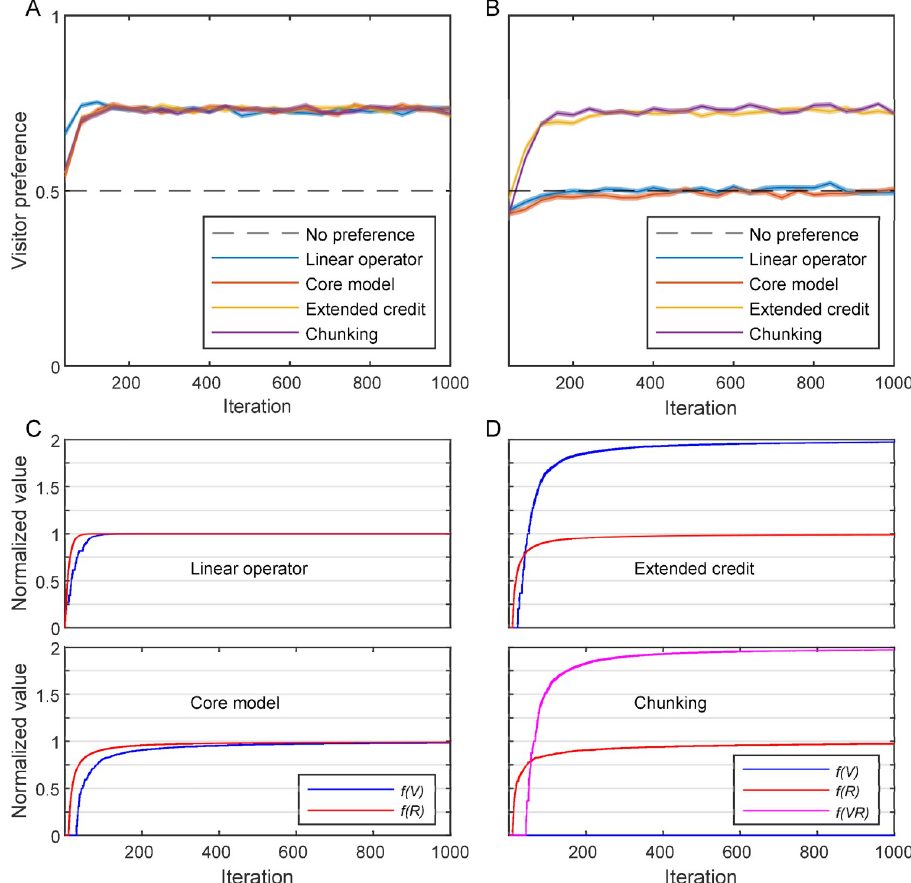
Fig 3. Simulating laboratory environments. Four types of learners are compared in the ‘basic two-choice task’ (A) and the ‘laboratory market problem’ (B) : blue–A linear operator learner ( α = 0.1; see text); orange–the core model; yellow–the extended credit model; purple–the chunking model (with C = 2); black dashed line–the expected choices p with no preference (0.5). The preference towards a visitor client, measured as the proportion of choosing a visitor out of all visitor–resident encounters, is plotted as a function of time (iterations), in bins of 40 trials. Both laboratory environments were simulated using 1,000 feeding trials (with an empty trial after each feeding trial). The plots depict the mean of 100 simulations for each learner (shades–standard error of the mean). ( C) The value of the different states as perceived by the nonsuccessful models, the linear operator (top) and the core model (bottom), in a single simulation of the ‘laboratory market problem’: blue– V ; red– R . ( D) The values perceived by the successful models, the extended credit model (top) and the chunking model (bottom) in a single simulation of the ‘laboratory market problem’: blue– V ; red– R ; magenta– VR . Note that the chunking model, in this task, quickly creates the VR chunk, even before any value is attached to V itself. (Underlying data in S1 Data). model and the chunking model were capable of solving the ‘laboratory market problem’, i.e., to develop a strong preference towards the visitor client (Fig 3B, yellow and purple lines, respectively). The inability of the core and linear operator models to solve the laboratory mar- ket problem is reflected in their indifferent ‘normalised values’ of R , f ( R ), and V , f ( V ), both of which approach 1 (Fig 3C). This result is expected since the value of each state is updated inde- pendently of any past and future state or reward, and both states (client types) provide the exact same immediate reward. In the extended credit model that solves the problem success- fully, the ‘normalised value’ of R , f ( R ), approaches 1, while the ‘normalised value’ of V , f ( V ), approaches 2 (Fig 3D, top panel). This was made possible because serving a resident always provides a single food item in this setup (as the visitor leaves) while the credit of choosing a